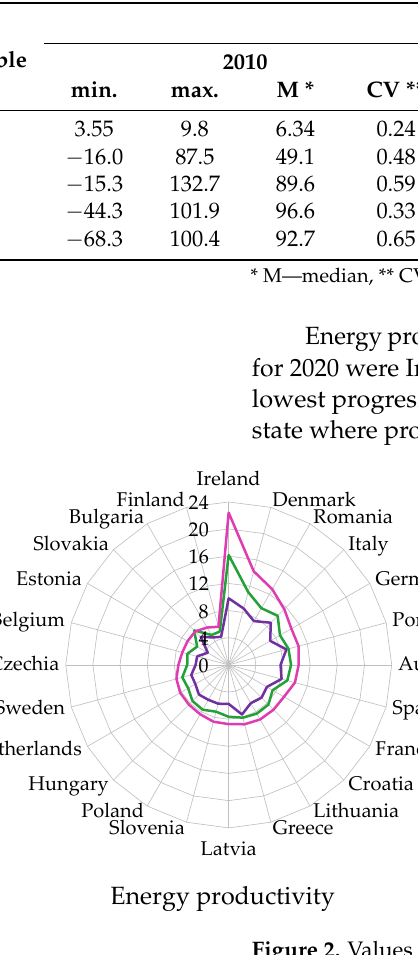
Table 4. Numerical characteristics of energy security indicators in specific years.